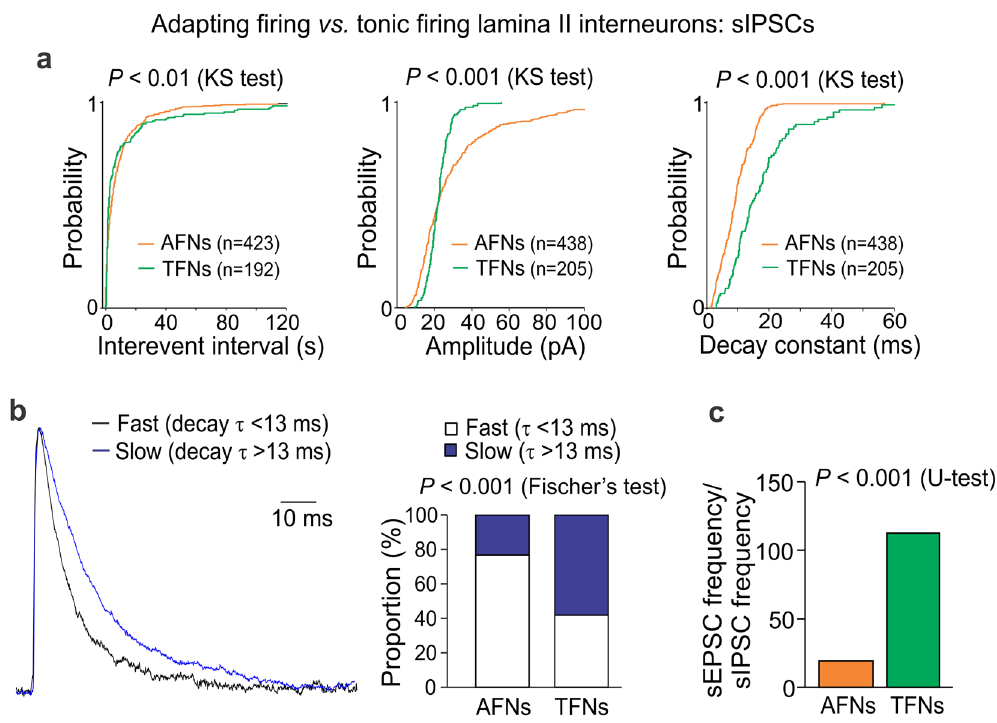
Figure 5. Heterogeneous inhibitory control of DH interneurons. ( a ) Cumulative probability plots for the inter- event interval, the amplitude and the decay constant of sIPSCs in AFNs and TFNs in control. The Kolmogorov- Smirnov (KS) test significance with the number of events for analysis is indicated. ( b ) Left, the fast sIPSCs ( τ < 13 ms, black line) and slow sIPSCs ( τ > 13 ms, blue line) in AFNs in control. The currents are average from 112 fast ( τ = 10.5 ms) and 44 slow ( τ = 19.6 ms) events recorded in 15 cells. Right, the relative proportions of fast to slow inhibitory currents in AFNs and TFNs in control. The Fisher’s exact test significance is indicated. ( c ) The average balance between neuronal excitation and inhibition, estimated as the ratio of the median sEPSC frequency to the median sIPSC frequency recorded from individual AFNs (n = 14 cells) or TFNs (n = 10 cells) in control. The Mann-Whitney U-test significance is